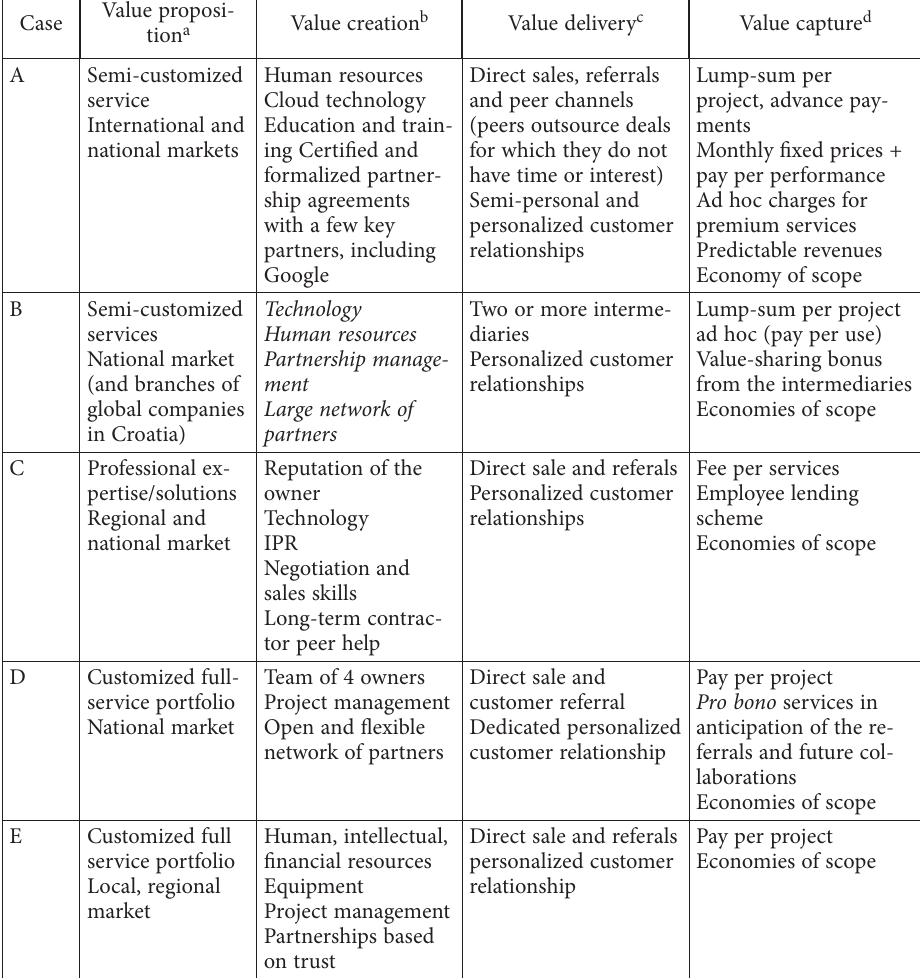
Table 3. Key dimensions and core components in business model (BM) design (source: created by